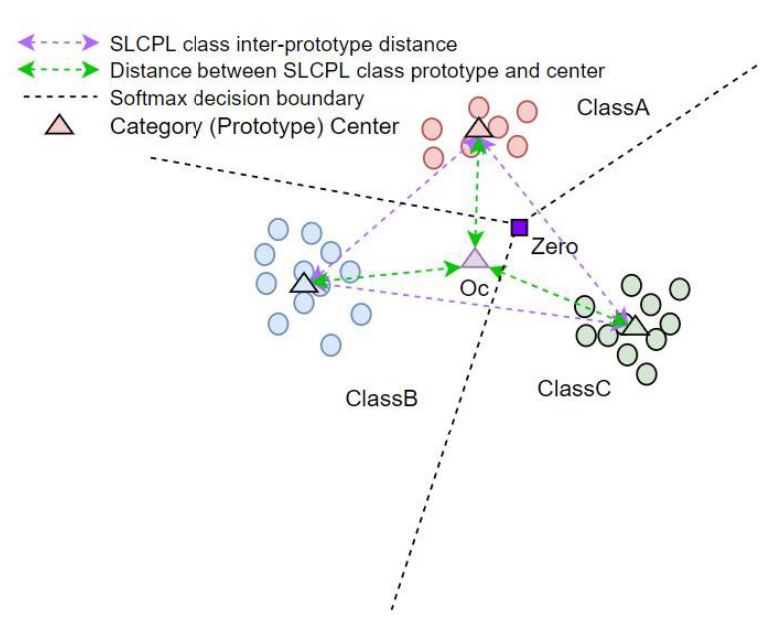
Figure 4. SLCPL 1dividing line. Figure 4. SLCPL feature space and softmax dividing